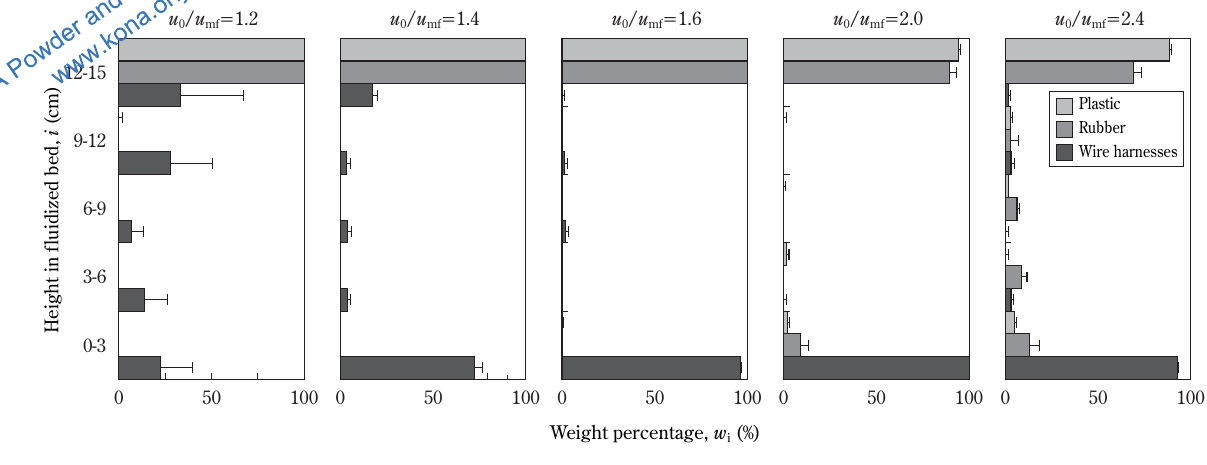
Fig. 12 Weight percentages of plastic, rubber, and wire harnesses at each height in the fluidized bed at various air velocities